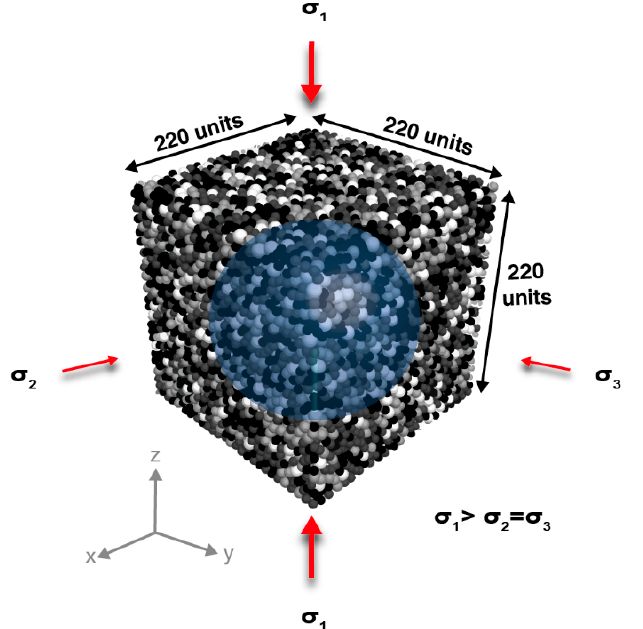
Figure 2. The 3D Discrete Element Method (DEM) cubic isotropic sample. The initial particle setup for the triaxial test are under strain ( ε z ) = 0%. The blue sphere in the center of the pre-tested cubic sample presents the location of the measurement sphere. The main stress ( σ 1 ) is acting parallel to the z-axis; σ σ 2 and 3 are equal and act parallel to axes x and y,